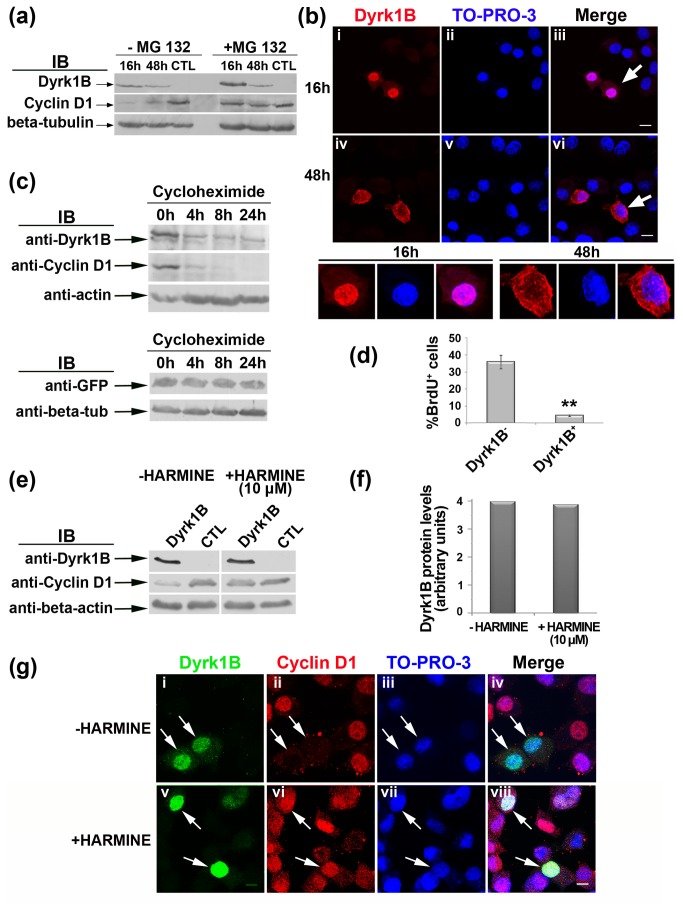
Dyrk1B protein expression and turn-over in Neuro 2a cells.(a) Dyrk1B expression in transiently transfected Neuro 2a cells was examined at 16 h and 48 h post-transfection in the presence or in the absence of the specific proteasome inhibitor MG132. Dyrk1B is not detectable in non-transfected Neuro 2a cells (CTL) with available antibody, while transgene Dyrk1B, obvious at 16h, is decreased overtime in a proteasome-specific manner (upper panel). In the absence of MG132, cyclin D1 levels are inversely related to Dyrk1B (middle panel) while in the presence of MG132 cyclin D1, also degraded via the proteasome, is maintained despite persisting Dyrk1B expression (middle panel); β-tubulin indicates protein loading (lower panel). (b) Dyrk1B is localized in the nucleus of Dyrk1B+ Neuro 2a cells 16 h post-transfection, while at 48 h it is mainly cytoplasmic as shown by immunocytochemistry and confocal microscopy. The cells depicted by arrows at 16h and 48h, respectively, are shown at higher magnification. Different image acquisition settings were used at 16h and 24h to compensate for signal reduction at 48h. Scale bar: 10 μm. (c) Dyrk1B protein turn-over in Neuro 2A cells. Cells were transfected with Dyrk1B and allowed for expression 16 h after transfection. Cells were then treated with cycloheximide for different times as indicated and subjected to Western blot analysis. (d) Dyrk1B reduces BrdU incorporation in transiently transfected Neuro 2a cells after 16 h of expression. **Student’s t-test, p=0.00146, n=5. (e) In the presence of 10 μM harmine, a specific kinase inhibitor of the Dyrk1 protein family, the Dyrk1B-dependent down-regulation of cyclin D1 is inhibited in Neuro 2a cells (middle panel) without affecting Dyrk1B protein levels (upper panel). Lanes show Neuro 2a cells transiently transfected with Dyrk1B and allowed 16 h for expression, or non-transfected cells (CTL), harvested and immunoblotted with the indicated antibodies. (f) Quantification of Dyrk1B protein levels normalized relative to β-actin, in the presence or absence of 10 μΜ harmine. (g) Cyclin D1 is wiped out from the nuclei of Dyrk1B+ transiently transfected Neuro 2a cells (arrows, i-iv) but is clearly maintained in the nucleus of Dyrk1B+ cells in the presence of harmine (arrows, v-viii). Cells were double labeled for Dyrk1B (green) and cyclin D1 (red) while nuclei were visualized using TO-PRO-3 (blue). The merged pictures are shown (iv, viii). Scale bar: 8 μm.